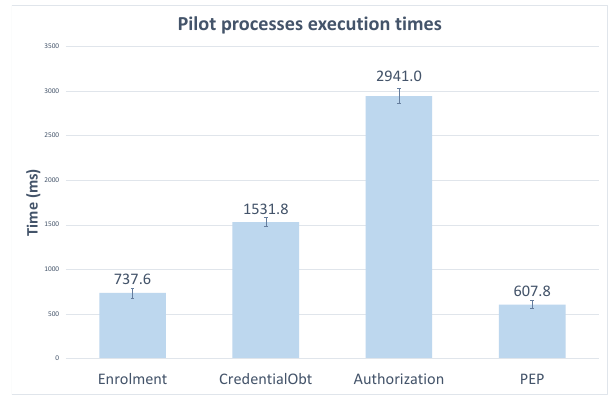
Figure 10. PoC implementation execution time for the different